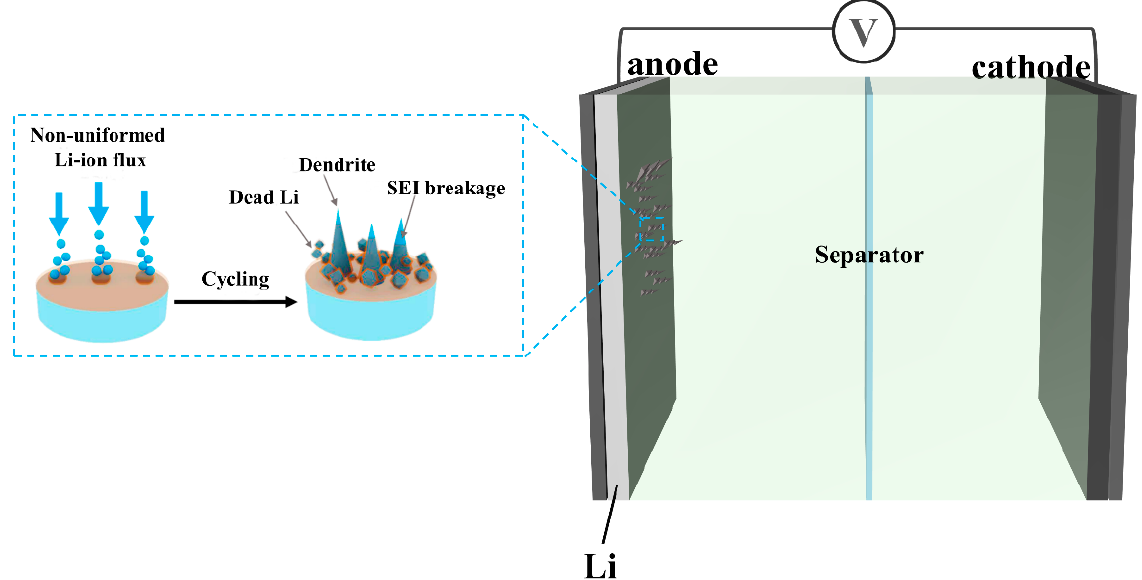
Figure 1. Formation processing of lithium dendrites in lithium metal batteries.